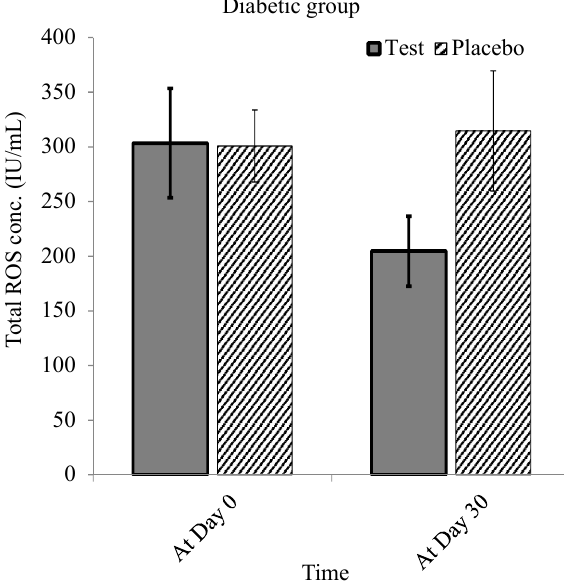
Fig. 3. Total ROS levels for diabetic participants receiving anthocyanin extract or placebo at day 0 and day 30. Values are expressed as mean ±SD